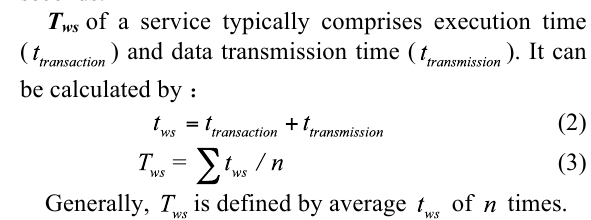
Fig.1. A composite service example: personal multimedia delivery